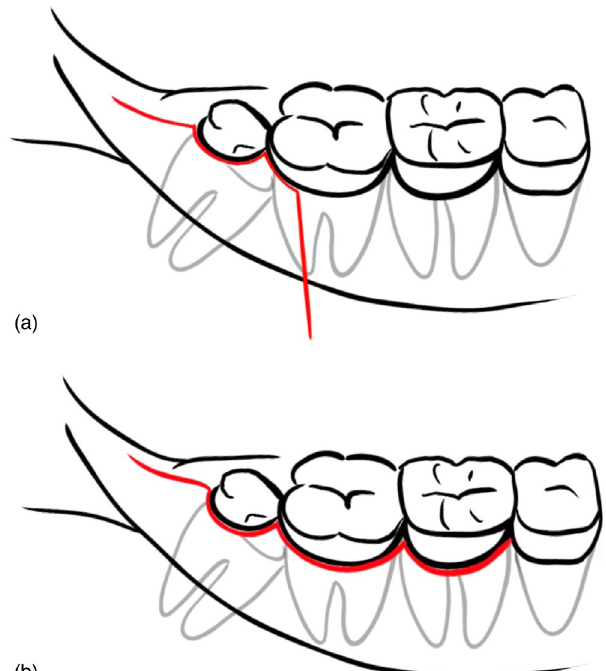
Fig. 4. Illustration of the most commonly performed fl ap designs to remove impacted mandibular third molar: (A) triangular fl ap (B) envelope fl